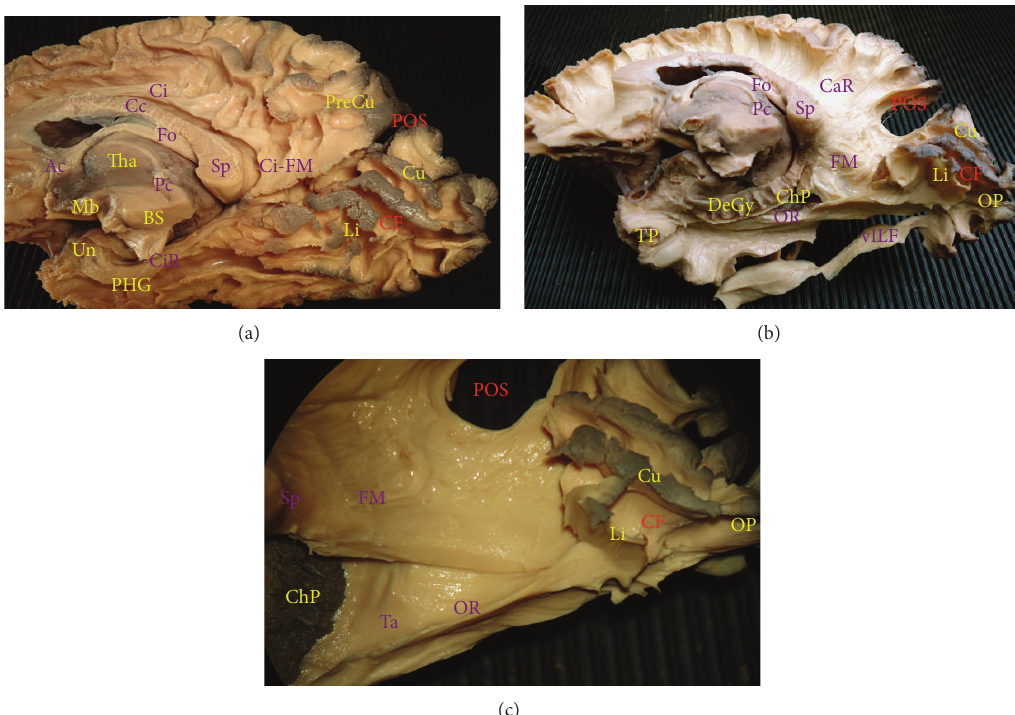
Figure 4: (a) Medial view of a right hemisphere after the initial dissection of cortex of the cingulate gyrus. The whole cingulum (Ci) is exposed with its extension from the subcallosal area to the parahippocampal gyrus (PHG) as the radiation of cingulum (CiR) until the region of the uncus. Posterior with respect to the splenium (Sp) of the corpus callosum (CC), a posterior component of the Ci reaches the cuneal and precuneal cortices, forming the most medial part of the forceps major (FM). (b) After the removal of the Ci and further dissection of the CC, the radiating callosal fibres (CaR) can be demonstrated. Once the hippocampus and the PHG have been removed, the lateral ventricle is opened with choroid plexus (ChP) shown at the medial portion of the trigone. The medial wall of the trigone is composed of callosal fibres of the FM, which end close to the optic radiation (OR) fibres on both sides of the calcarine fissure (CF). (c) The medial wall of the ventricle is opened cutting the FM fibres in order to expose the tapetal callosal fibres, which run within the lateral wall of the ventricle composing the deepest layer of the sagittal stratum of Sachs (SSS). The tapetal fibres end following the OR fibres on the medial surface of the cuneal and lingual regions, partially overlapped with the dorsal component of OR. Fo: fornix; Ac: anterior commissure; Pc: posterior